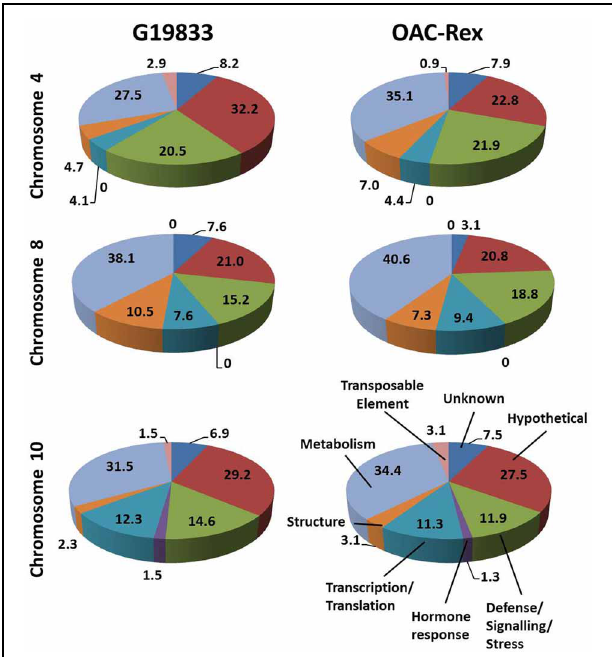
FIGURE 3 | Distributions of annotated genes in the CBB-marker associated regions among functional categories. The genes from each region were BLASTed against the NCBI nucleotide, EST and protein databases, then categorized into 8 categories: Unknown/No Match; Hypothetical Protein; Defense/Signaling/Kinase; Hormone Response; Transcription/Translation Factor; Structural; Metabolism and Transposable Element. The percentage for each category are listed on in the figure.